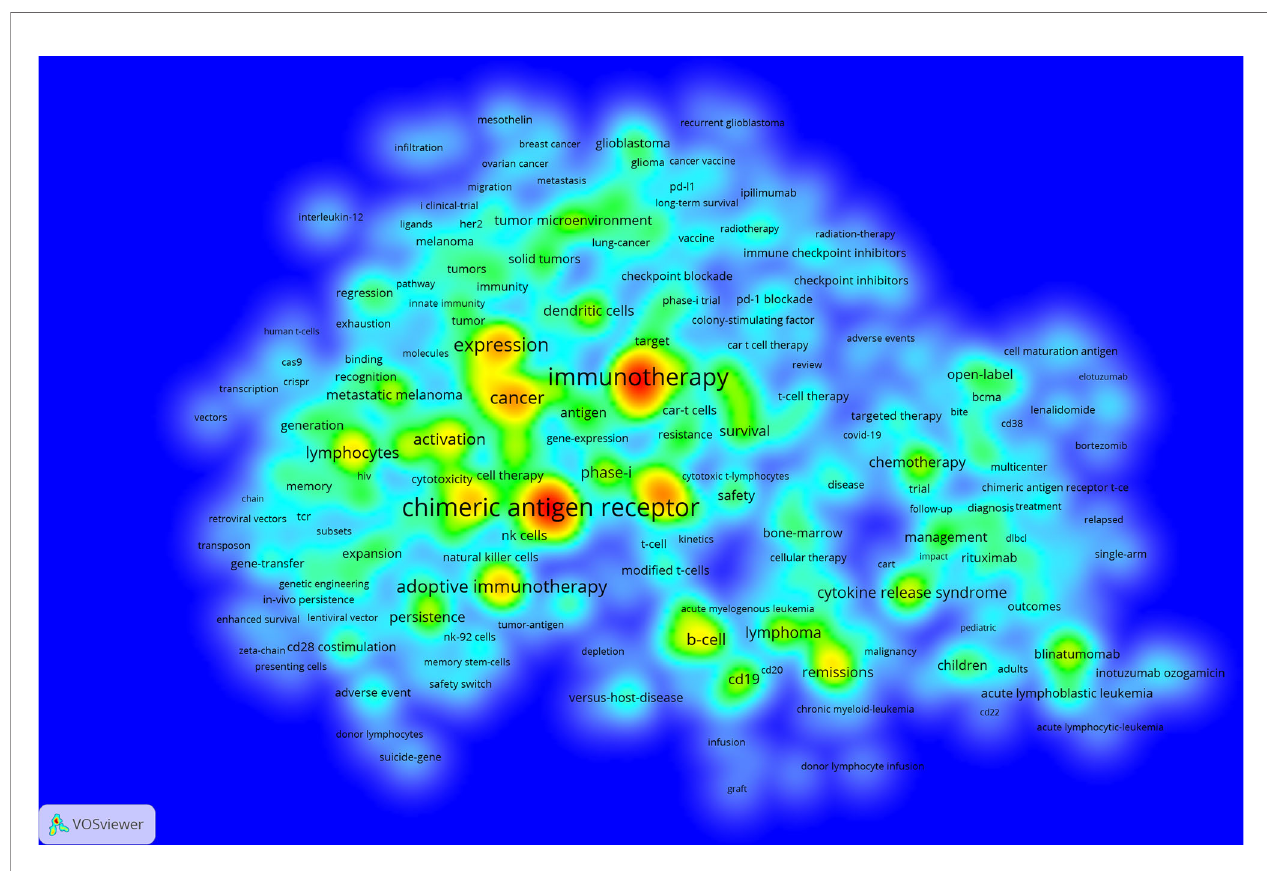
FIGURE 7 | The co-occurrence density map of keywords related to CAR-T cell research. Minimum number of occurrences of keywords ≥